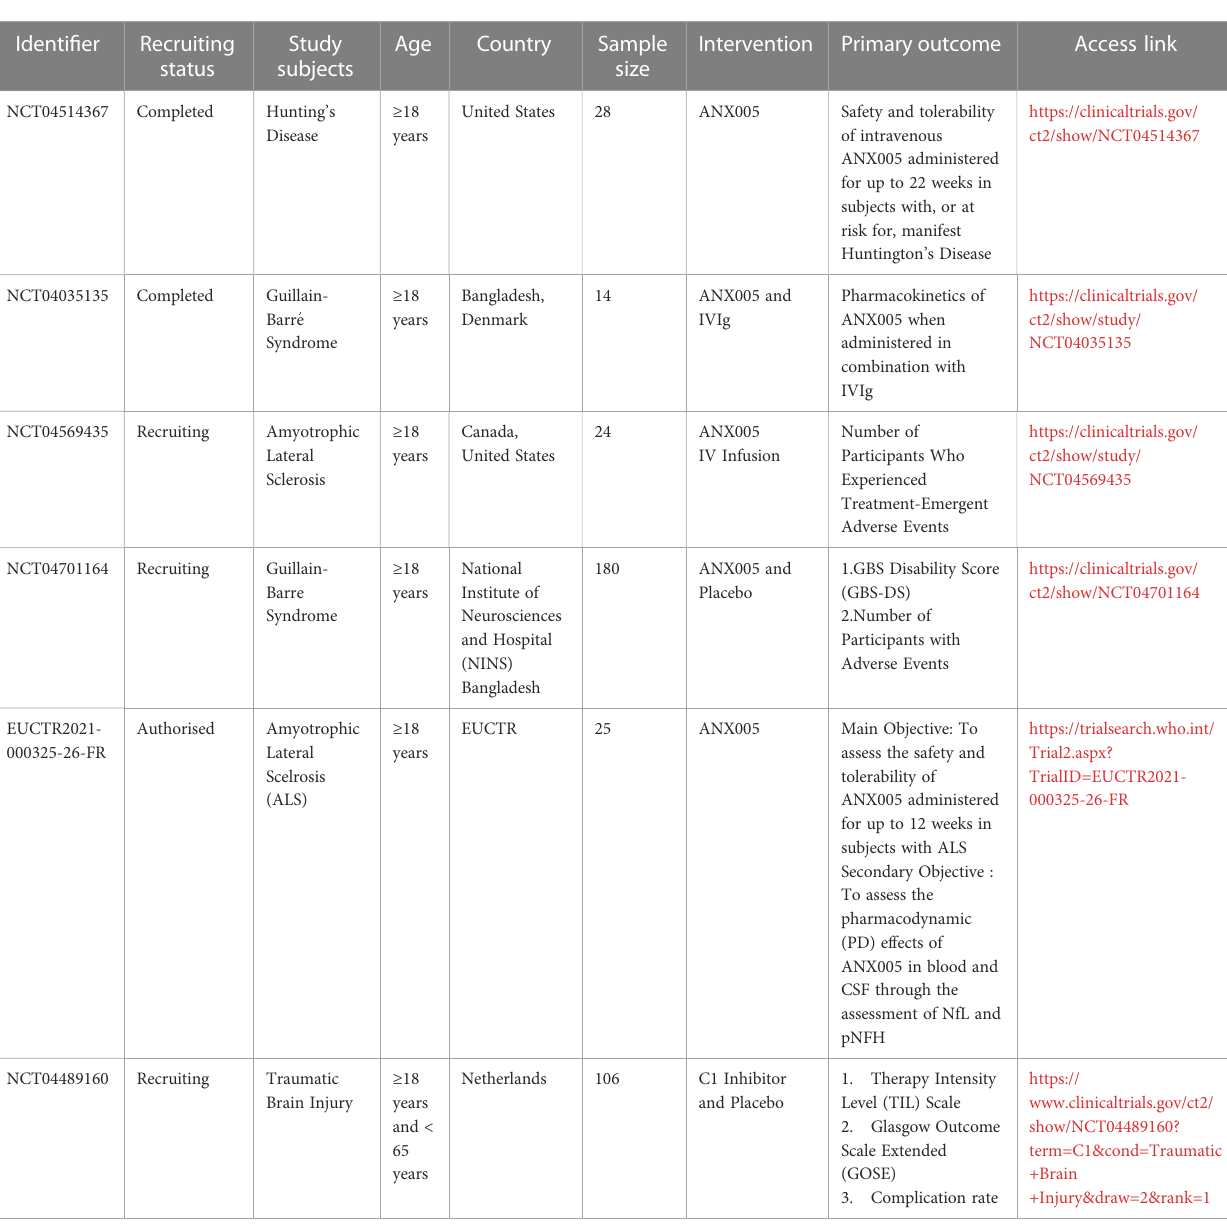
TABLE 2 Anti-C1q clinical trials on neurological